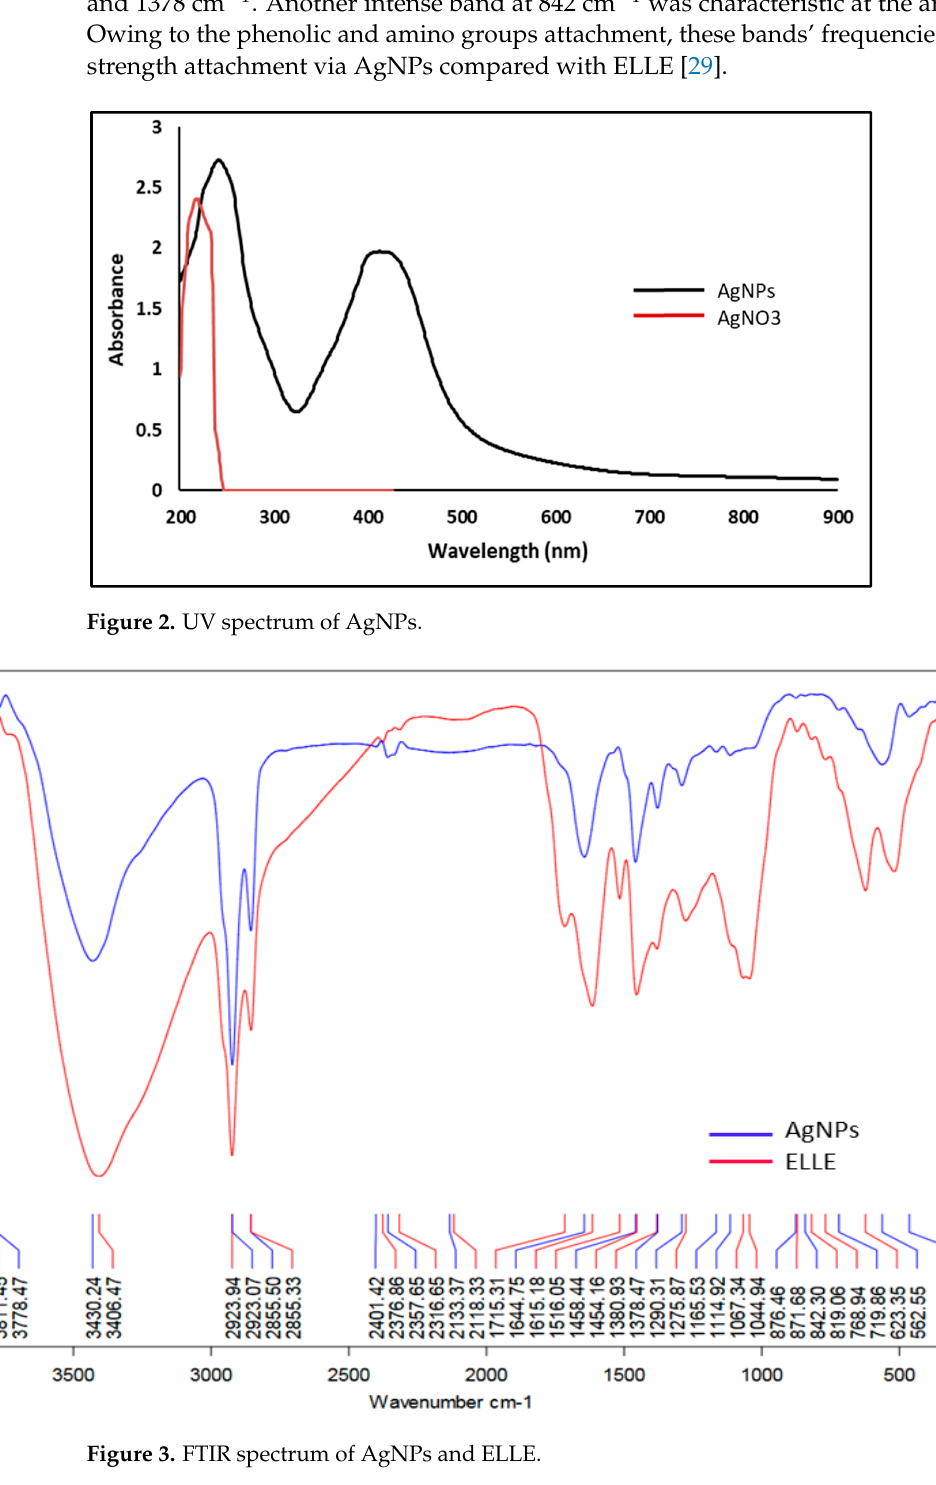
Figure 4. Electron micrographs of the green synthesized AgNPs capped with ELLE. ( A ) TEM and ( B ) SAED.